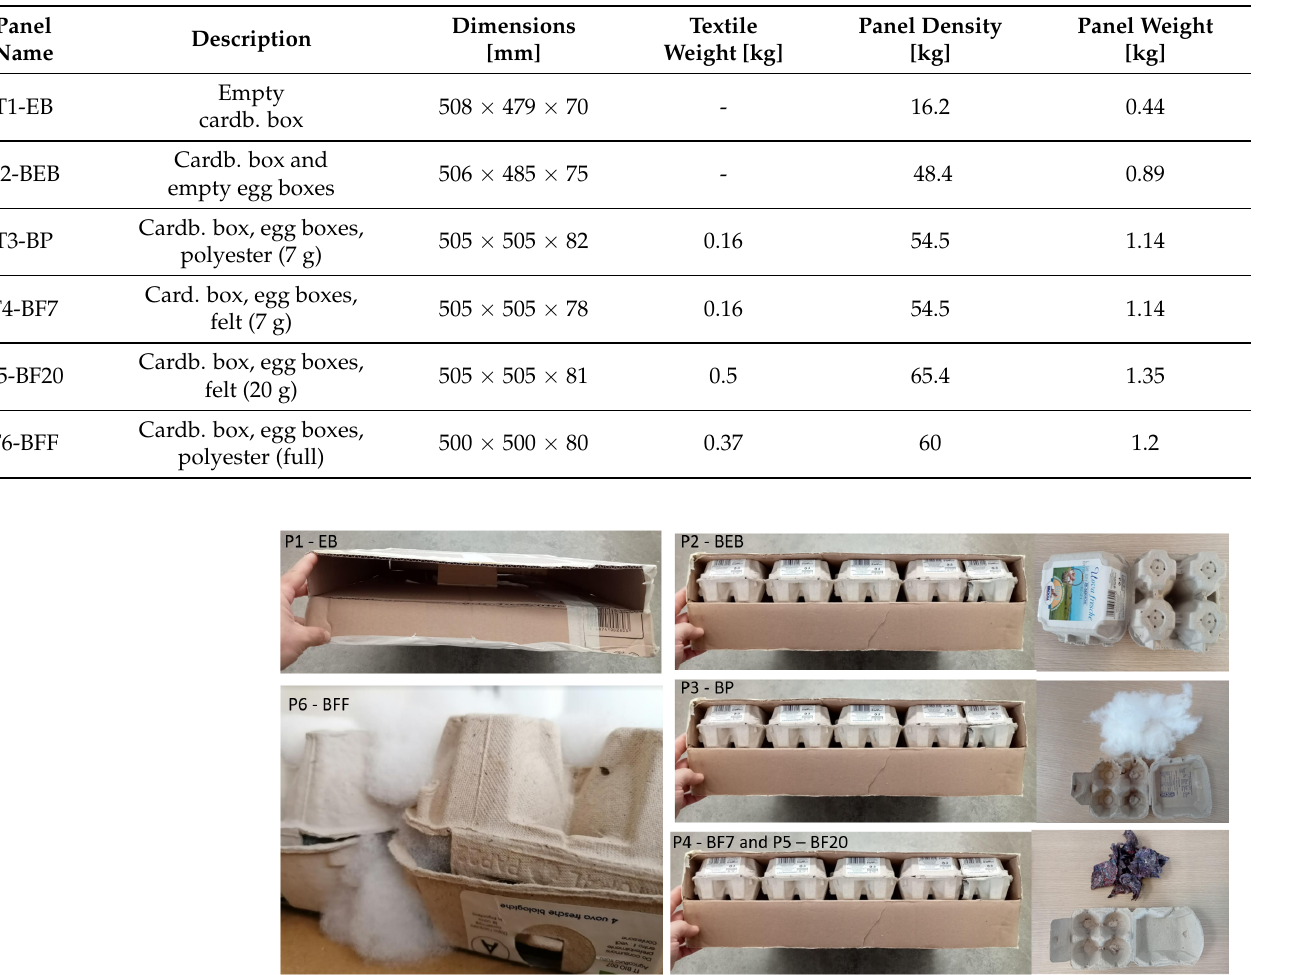
Table 1. Details of the panels realized for the thermal tests.